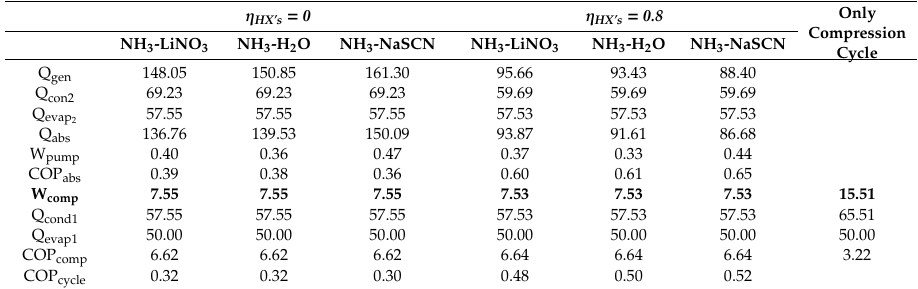
Table 6. Thermal capacity and performance of the compression–absorption system and traditional vapor compression refrigeration cycle.